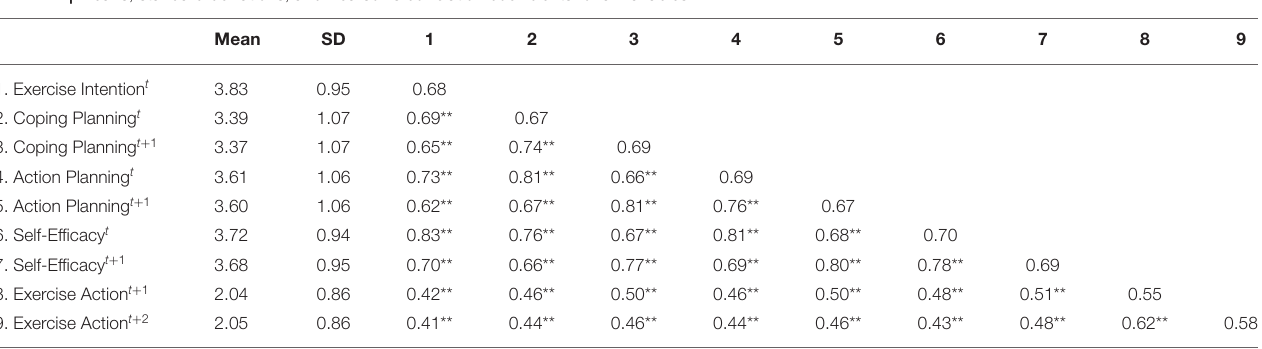
TABLE 1 | Means, standard deviations, and Pearson’s correlation coefficients for all